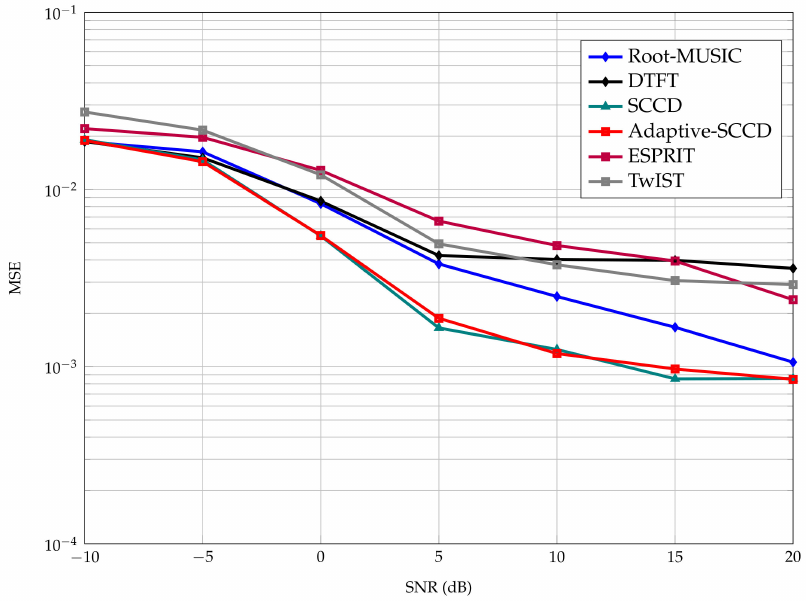
Figure 3. MSE versus SNR for p = 5 normalized